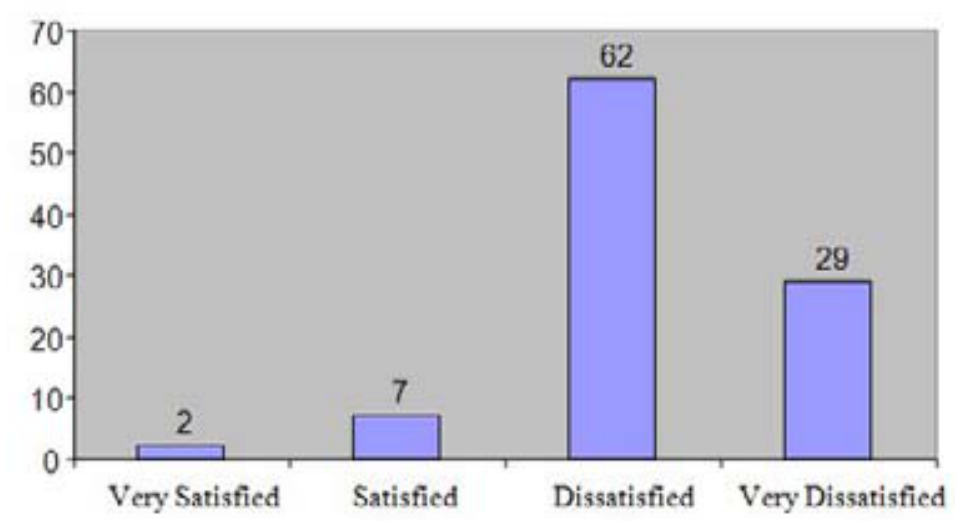
Figure 3 . Levels of satisfaction of students in